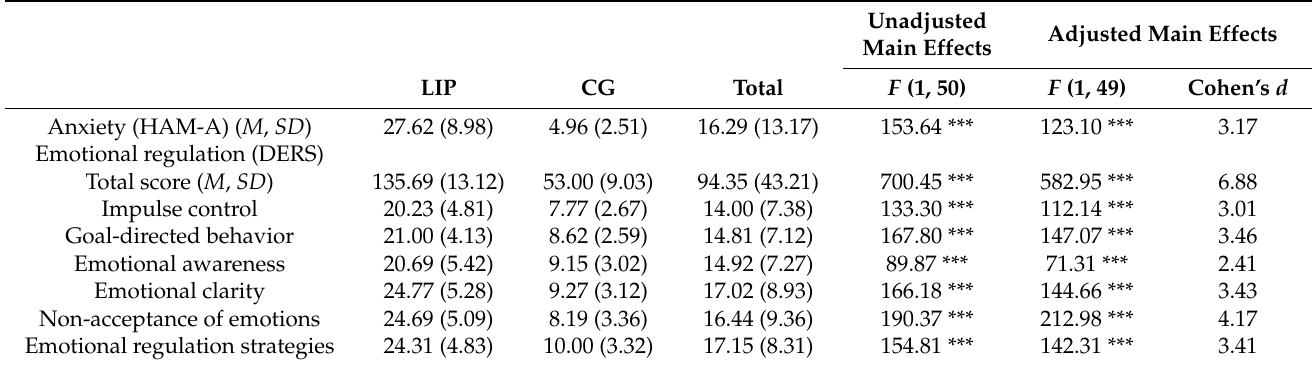
Table 3. Analysis of Covariance: Group Differences in Anxiety and Difficulties in Emotional Regula- tion Controlling for BMI.